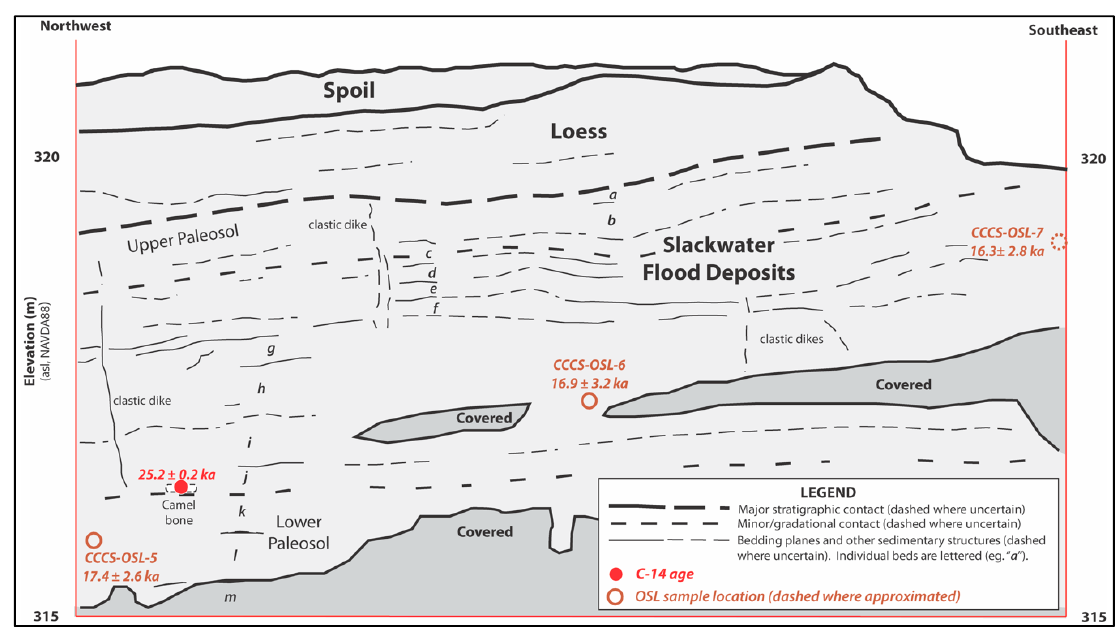
Figure 7. Stratigraphic interpretation of a measured section at CCSH-MS, where a Camelops hesternus metatarsal was found, approximately 300 m west-northwest of the CCMS excavation. Thirteen slackwater flood beds (designated by lower case letters) have been identified here. Note the location of OSL samples.